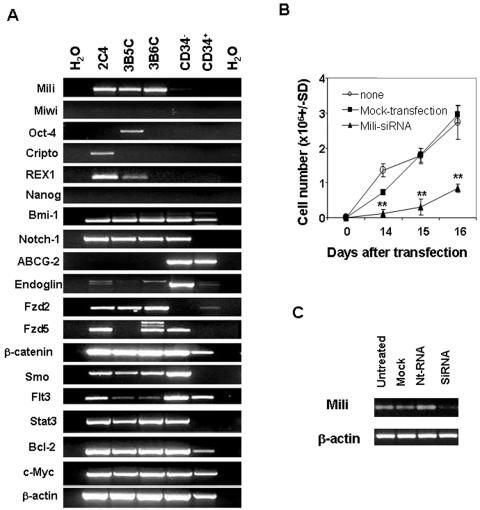
Exclusive expression of piwil2 and embryonic stem cell-related genes in pCSCs.A, Exclusive expression of mili (piwil2) gene in pCSCs: Total RNA was isolated randomly from 2C4, 3B5C and 3B6C cell cultures at various times or from the CD34+Lin− and CD34−Lin− BM cells of B6 mice, which were purified by FACS Aria in 3 separate experiments, and was subject to RT-PCR analysis for embryonic, germ-line, and adult stem cell-related stemness genes and oncogenic genes. The data represent at least 3 experiments. B, Inhibition of pCSC expansion in vitro by mili-specific siRNA: 2C4 cells (100 cells/well) were either transfected or not by mili-specific siRNA (100 nMol) or mock-transfected in triplicate in 24-well plates. The cells were counted at indicated times. The data represent 5 experiments. **, p<0.01 as compared to the mock- or non-transfected groups. C, Knockdown of mili mRNA by mili-specific siRNA: 2C4 cells (1×106/well) were transfected by mili-siRNA or scramble nucleotide (nt) RNA, and harvested 48 hrs post transfection. The expression of mili mRNA was revealed by RT-PCR. The data represent 3 experiments.